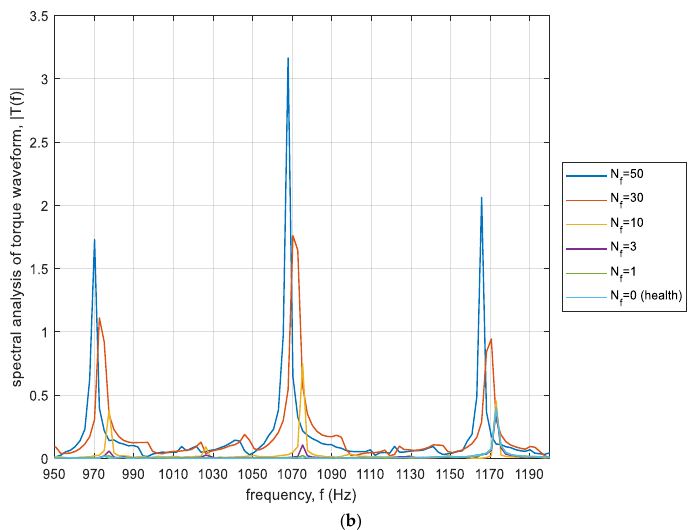
Figure 13. Spectral analysis of the torque waveform of a faulty motor limited in frequency: ( a ) Figure13. Spectralanalysisofthetorquewaveformofafaultymotorlimitedinfrequency: ( a )400–650Hz 400–650 Hz and ( b ) 950–1200 Hz, at T L = 0 Nm. and ( b ) 950–1200 Hz, at T L = 0 Nm. Energies 2020 , 13 , x FOR PEER REVIEW